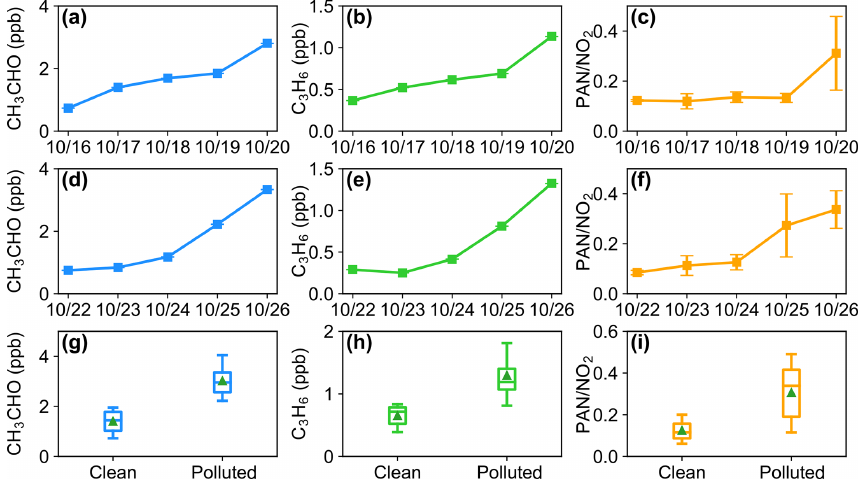
Figure 8. Observed concentrations of CH 3 CHO (ppb), C 3 H 6 (ppb), and PAN / NO 2 ratios at 08:00LT (a–c) during episode 1 (16–20 Octo- ber) and (d–f) episode 2 (22–26 October) at the SDZ site. (g–i) Comparisons between concentrations of CH 3 CHO, C 3 H 6 , and PAN / NO 2